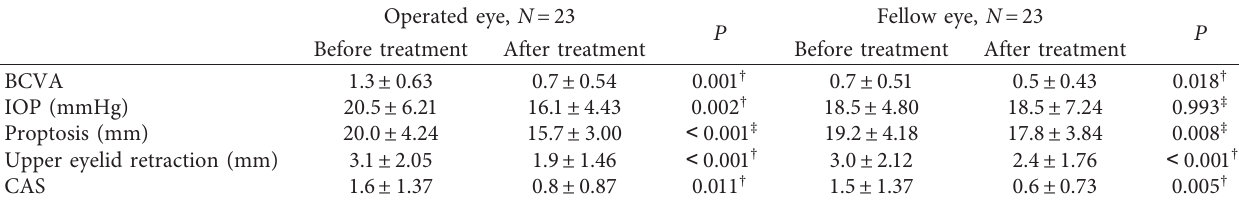
Table 2: Clinical characteristics of the operated eyes and fellow eyes in patients with bilateral DON before and after treatment.